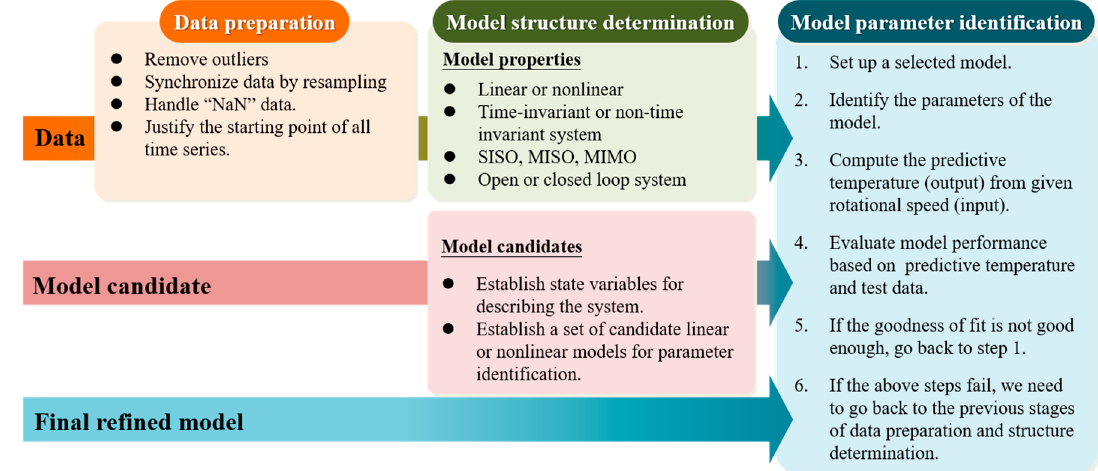
Figure 9. Procedure of thermo-feature identification.